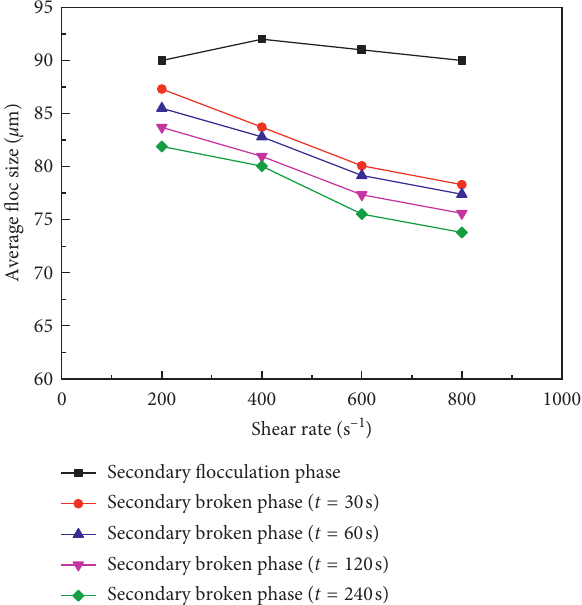
Figure 7: The variation of average floc size with shear rate during different shear times in the secondary flocculation and secondary broken phases.